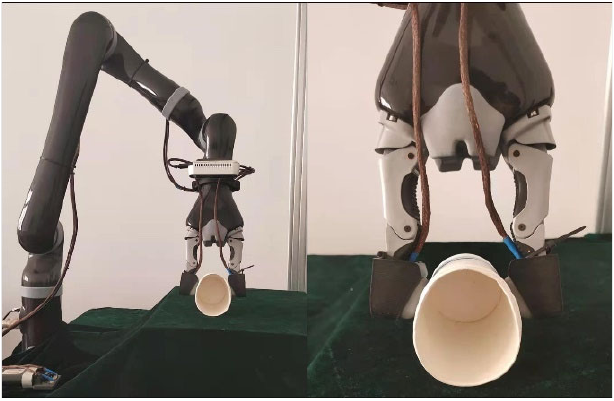
Figure 1. Robot operating platform that is picking up a paper